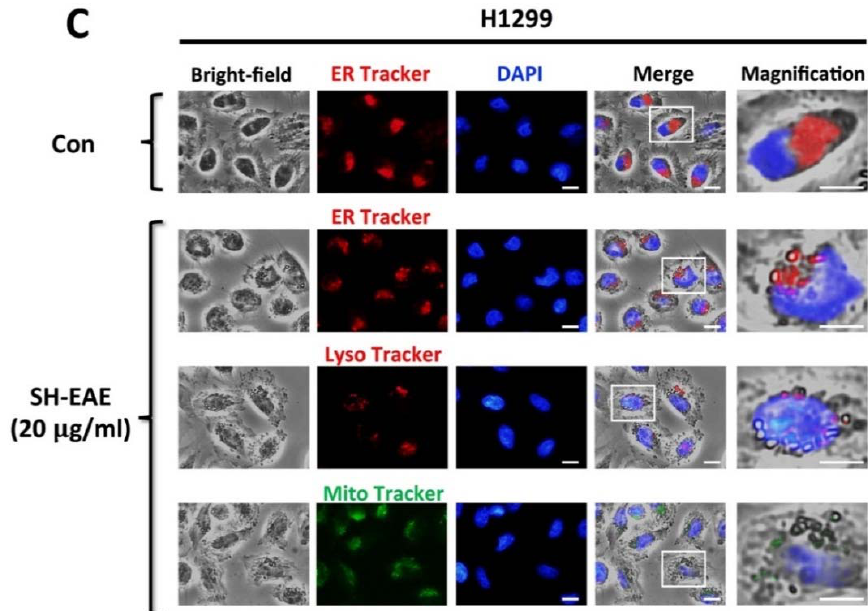
Figure 3. SH ‐ EAE induced cytoplasmic vacuolization in NSCLC cells. Comparison of ER morphology affected by SH ‐ EAE, Tg or Tm. ( A ) H1299 and ( B ) H460 cells expressing the fluorescent ER ‐ Tracker were treated with SH ‐ EAE (20 μ g/mL), Tg (0.1 μ M), or Tm (0.5 μ g/mL) for 48 h and analyzed by Nikon Eclipse TE2000U inverted fluorescence microscope (Nikon Corporation, Tokyo, Japan). The images on the left panel were taken with a bright ‐ field objective. The second panel is that stained with ER ‐ Tracker™ Red dye. The third panel is that stained with DAPI. The fourth panel is an overlay of the bright ‐ field images with the fluorescence images. The last panel is a magnification of the boxed region. Scale bar indicates 50 μ m. Representative images of H1299 and H460 cells for each condition over three independent experiments are shown. ( C ) Staining for various organelles in the SH ‐ EAE ‐ treated H1299 cells. Cells exhibiting SH ‐ EAE ‐ induced vacuolization were stained for trackers of ER (red), lysosomes (red), and mitochondria (green). Cell nuclei were stained with DAPI. Scale bar indicates 25 μ m. None of the lysosome or mitochondria trackers overlapped with SH ‐ EAE ‐ induced vacuolization.